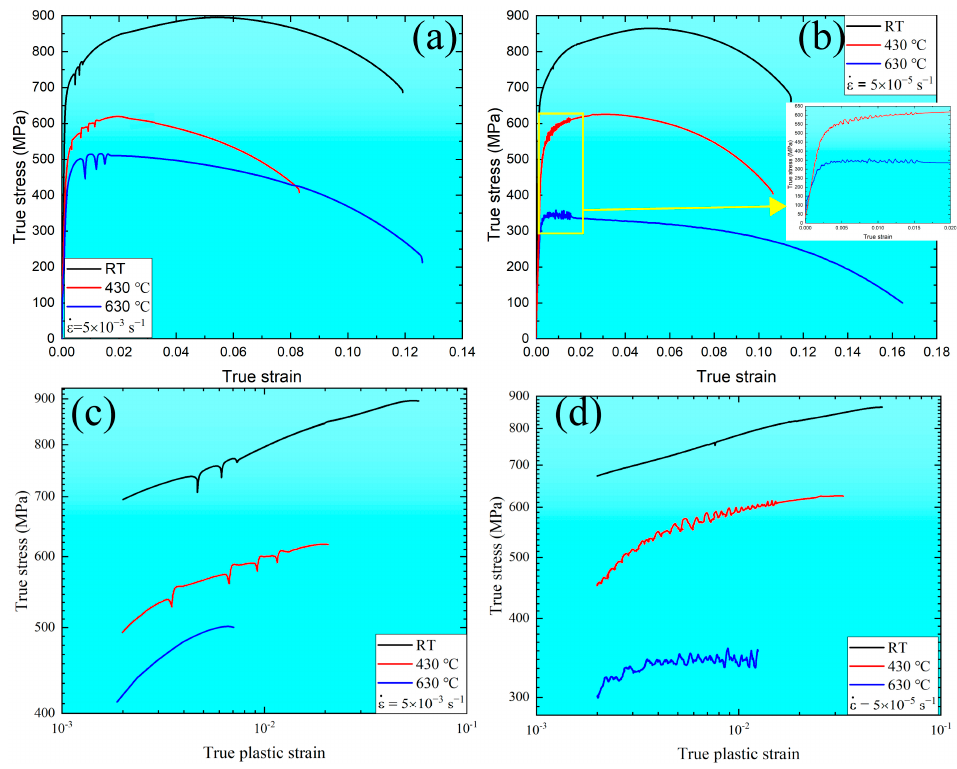
Figure 1. Effect of strain rates and temperatures on the true stress–true strain and true stress–true plastic strain for MarBN steel: ( a , c ) at 5 × 10 − 3 s − 1 and ( b , d ) at 5 × 10 − 5 s − 1 . Table 1. Detailed tensile properties under different temperatures at strain rates of 5 × 10 − 3 s − 1 and 5 × 10 − 5 s − 1 .